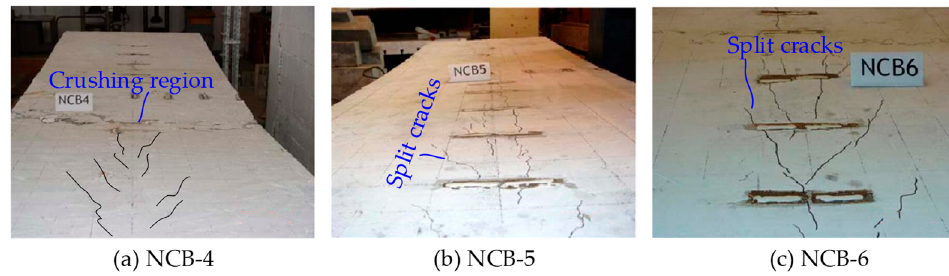
Figure 11. Analysis of failure modes by the calculated results.